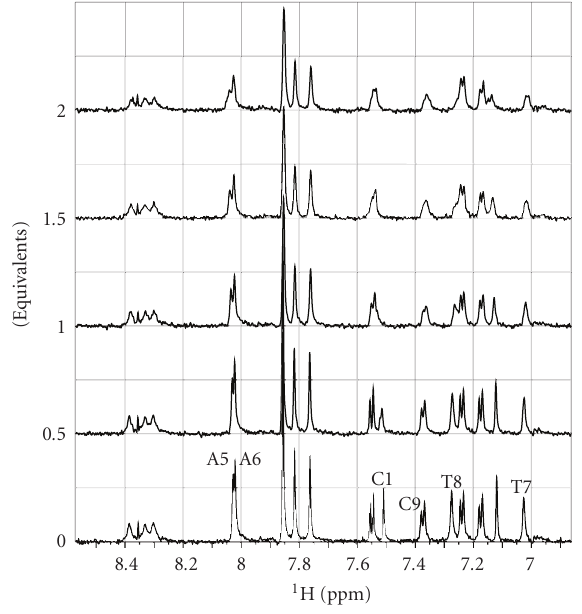
Figure 3: Expanded region of the 1 H-NMR titration of d(CGCGAATTCGCG) 2 with derivative 1 (700MHz, T = 25 ◦ C). 1mM (4mM single strand concentration), in 0.2 ml (H 2 O/D 2 O 9:1) bu ff er solution having 10 mM KH 2 PO 4 , 70mMKCl, 0.2 mM EDTA, and pH 7 . 0 . Equivalents of the drug are reported on the left of each spectrum. Residues that are slightly a ff ected by the binding are indicated.